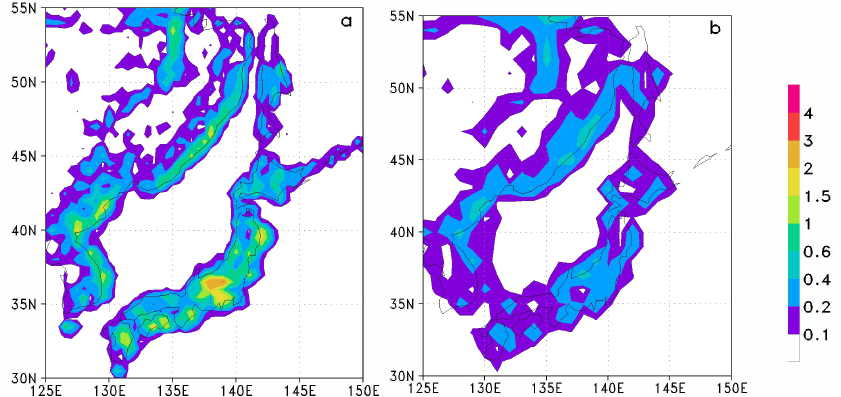
Fig. 1. Monthly averaged vertical component of the wind vector (10 − 5 Pas − 1 ) over Japan, as obtained using the (a) GPV and (b) GFS datasets for January 2008.